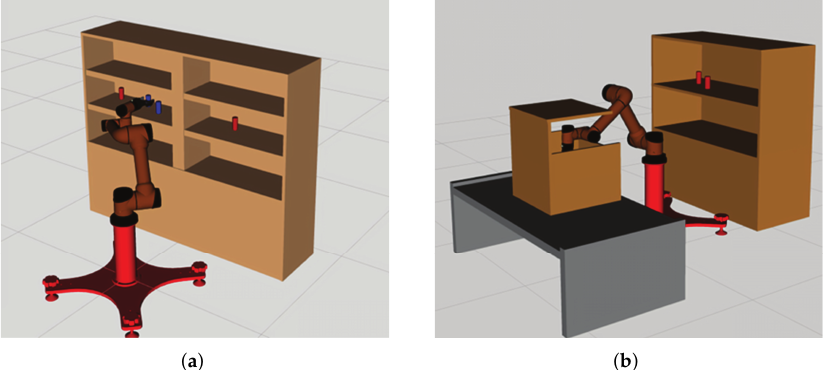
Figure 6. AUBO − i5 performs continuous pick-and-place tasks, shelf stacking ( a ), picking from deep bin ( b ).